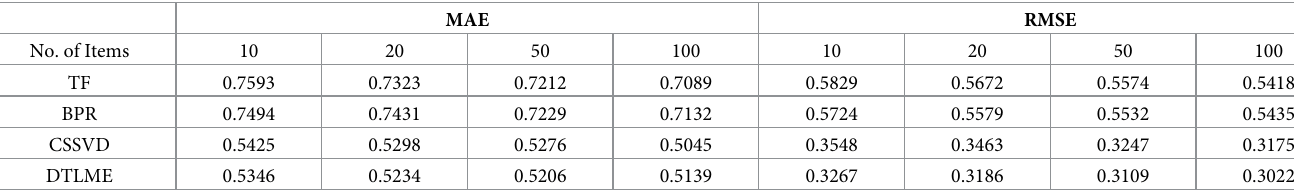
Table 5. Performance comparison for item cold-start problem on BE-dataset. MAE